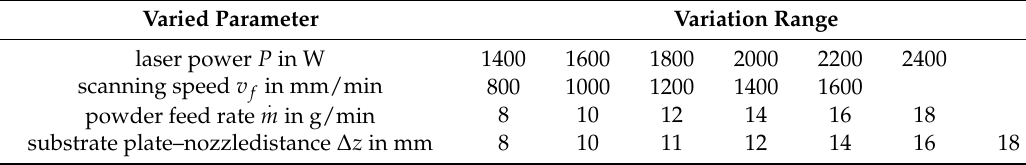
Figure A2. Temporally averaged NOP (over the intensity thresholds 163 digits, 417 digits and 948 digits ) over the laser power variation. The three curves follow the same characteristic, which is most pronounced in the curve of 948 digits. References 1. Toyserkani, E.; Khajepour, A.; Corbin, S.F. Laser Cladding , 1st ed.; CRC Press: Boca Raton, FL, USA, 2005; pp. 62–70. 2.